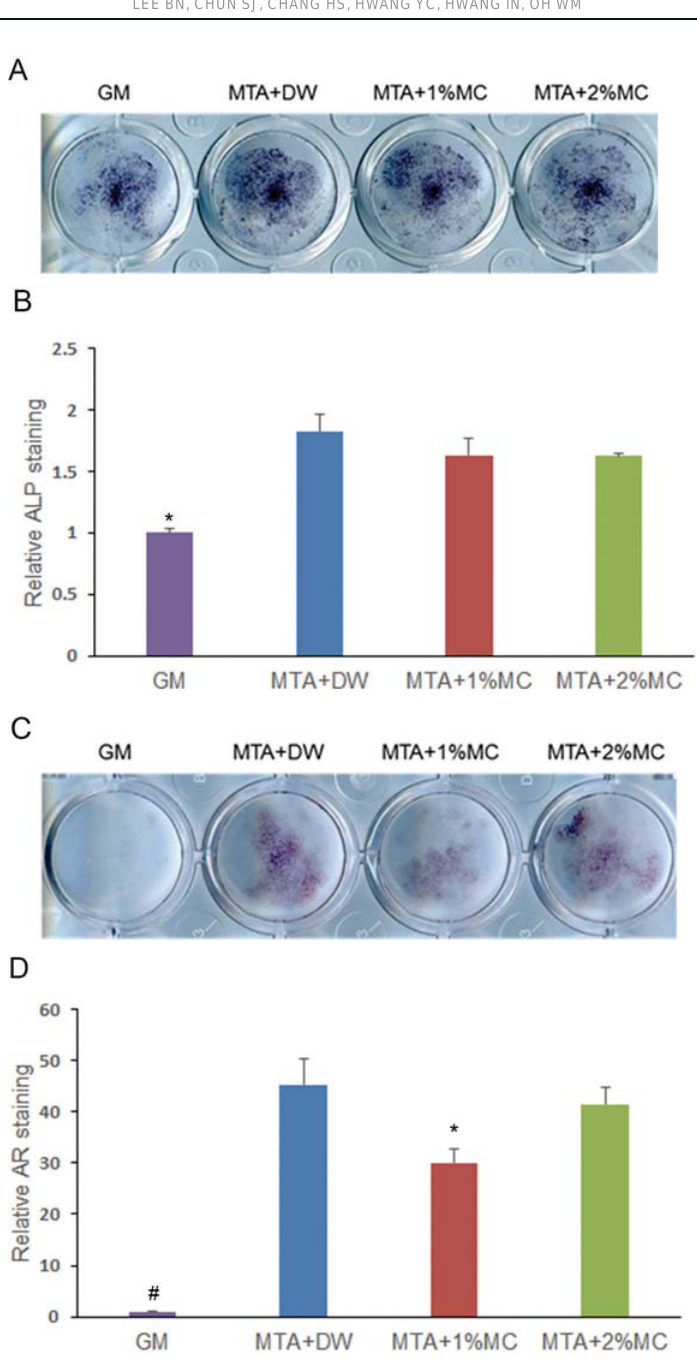
Figure 4- Alkaline phosphatase (ALP) staining and alizarin red staining in mPDL cells exposed to extracts of the tested materials. (A) (cid:51)(cid:75)(cid:72)(cid:81)(cid:82)(cid:87)(cid:92)(cid:83)(cid:72)(cid:3)(cid:72)(cid:91)(cid:83)(cid:85)(cid:72)(cid:86)(cid:86)(cid:76)(cid:82)(cid:81)(cid:3)(cid:82)(cid:73)(cid:3)(cid:36)(cid:47)(cid:51)(cid:3)(cid:71)(cid:88)(cid:85)(cid:76)(cid:81)(cid:74)(cid:3)(cid:82)(cid:86)(cid:87)(cid:72)(cid:82)(cid:74)(cid:72)(cid:81)(cid:76)(cid:70)(cid:3)(cid:71)(cid:76)(cid:73)(cid:73)(cid:72)(cid:85)(cid:72)(cid:81)(cid:87)(cid:76)(cid:68)(cid:87)(cid:76)(cid:82)(cid:81)(cid:3)(cid:69)(cid:92)(cid:3)(cid:87)(cid:75)(cid:72)(cid:3)(cid:87)(cid:72)(cid:86)(cid:87)(cid:72)(cid:71)(cid:3)(cid:80)(cid:68)(cid:87)(cid:72)(cid:85)(cid:76)(cid:68)(cid:79)(cid:86)(cid:3)(cid:76)(cid:81)(cid:3)(cid:80)(cid:51)(cid:39)(cid:47)(cid:3)(cid:70)(cid:72)(cid:79)(cid:79)(cid:86)(cid:3)(cid:68)(cid:87)(cid:3)(cid:24)(cid:3)(cid:71)(cid:17)(cid:3)(cid:11)(cid:37)(cid:12)(cid:3)(cid:52)(cid:88)(cid:68)(cid:81)(cid:87)(cid:76)(cid:191)(cid:72)(cid:71)(cid:3)(cid:71)(cid:68)(cid:87)(cid:68)(cid:17)(cid:3)(cid:11)(cid:38)(cid:12)(cid:3)(cid:48)(cid:68)(cid:87)(cid:85)(cid:76)(cid:91)(cid:3) (cid:80)(cid:76)(cid:81)(cid:72)(cid:85)(cid:68)(cid:79)(cid:76)(cid:93)(cid:68)(cid:87)(cid:76)(cid:82)(cid:81)(cid:3)(cid:82)(cid:73)(cid:3)(cid:80)(cid:51)(cid:39)(cid:47)(cid:3)(cid:70)(cid:72)(cid:79)(cid:79)(cid:86)(cid:3)(cid:82)(cid:69)(cid:86)(cid:72)(cid:85)(cid:89)(cid:72)(cid:71)(cid:3)(cid:69)(cid:92)(cid:3)(cid:86)(cid:87)(cid:68)(cid:76)(cid:81)(cid:76)(cid:81)(cid:74)(cid:3)(cid:70)(cid:68)(cid:79)(cid:70)(cid:76)(cid:88)(cid:80)(cid:3)(cid:71)(cid:72)(cid:83)(cid:82)(cid:86)(cid:76)(cid:87)(cid:86)(cid:3)(cid:76)(cid:81)(cid:3)(cid:87)(cid:75)(cid:72)(cid:3)(cid:72)(cid:91)(cid:87)(cid:85)(cid:68)(cid:70)(cid:72)(cid:79)(cid:79)(cid:88)(cid:79)(cid:68)(cid:85)(cid:3)(cid:80)(cid:68)(cid:87)(cid:85)(cid:76)(cid:91)(cid:3)(cid:68)(cid:73)(cid:87)(cid:72)(cid:85)(cid:3)(cid:20)(cid:23)(cid:3)(cid:71)(cid:17)(cid:3)(cid:11)(cid:39)(cid:12)(cid:3)(cid:52)(cid:88)(cid:68)(cid:81)(cid:87)(cid:76)(cid:191)(cid:72)(cid:71)(cid:3)(cid:71)(cid:68)(cid:87)(cid:68)(cid:17)(cid:3)(cid:58)(cid:72)(cid:3)(cid:82)(cid:69)(cid:86)(cid:72)(cid:85)(cid:89)(cid:72)(cid:71)(cid:3) (cid:68)(cid:3)(cid:75)(cid:76)(cid:74)(cid:75)(cid:72)(cid:85)(cid:3)(cid:36)(cid:47)(cid:51)(cid:3)(cid:72)(cid:91)(cid:83)(cid:85)(cid:72)(cid:86)(cid:86)(cid:76)(cid:82)(cid:81)(cid:3)(cid:68)(cid:81)(cid:71)(cid:3)(cid:80)(cid:76)(cid:81)(cid:72)(cid:85)(cid:68)(cid:79)(cid:76)(cid:93)(cid:68)(cid:87)(cid:76)(cid:82)(cid:81)(cid:3)(cid:76)(cid:81)(cid:3)(cid:70)(cid:72)(cid:79)(cid:79)(cid:86)(cid:3)(cid:72)(cid:91)(cid:83)(cid:82)(cid:86)(cid:72)(cid:71)(cid:3)(cid:87)(cid:82)(cid:3)(cid:87)(cid:72)(cid:86)(cid:87)(cid:72)(cid:71)(cid:3)(cid:80)(cid:68)(cid:87)(cid:72)(cid:85)(cid:76)(cid:68)(cid:79)(cid:86)(cid:3)(cid:70)(cid:82)(cid:80)(cid:83)(cid:68)(cid:85)(cid:68)(cid:87)(cid:76)(cid:89)(cid:72)(cid:79)(cid:92)(cid:3)(cid:90)(cid:76)(cid:87)(cid:75)(cid:3)(cid:87)(cid:75)(cid:72)(cid:3)(cid:70)(cid:82)(cid:81)(cid:87)(cid:85)(cid:82)(cid:79)(cid:17)(cid:3)(cid:13)(cid:83)(cid:31)(cid:17)(cid:19)(cid:24)(cid:15)(cid:3)(cid:70)(cid:82)(cid:80)(cid:83)(cid:68)(cid:85)(cid:72)(cid:71)(cid:3)(cid:87)(cid:82)(cid:3)(cid:87)(cid:75)(cid:72)(cid:3)